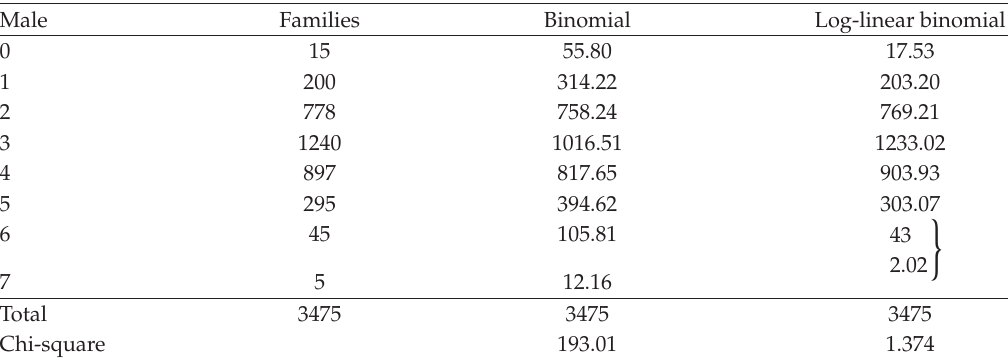
Table 3: Numbers of male children in 3475 families of size